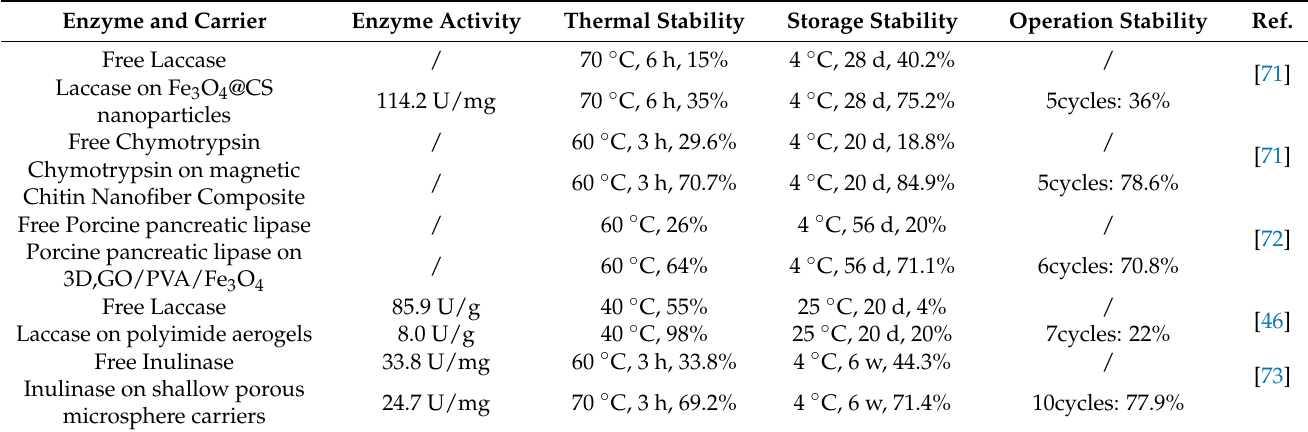
Table 1. Performance parameters of various free and immobilized